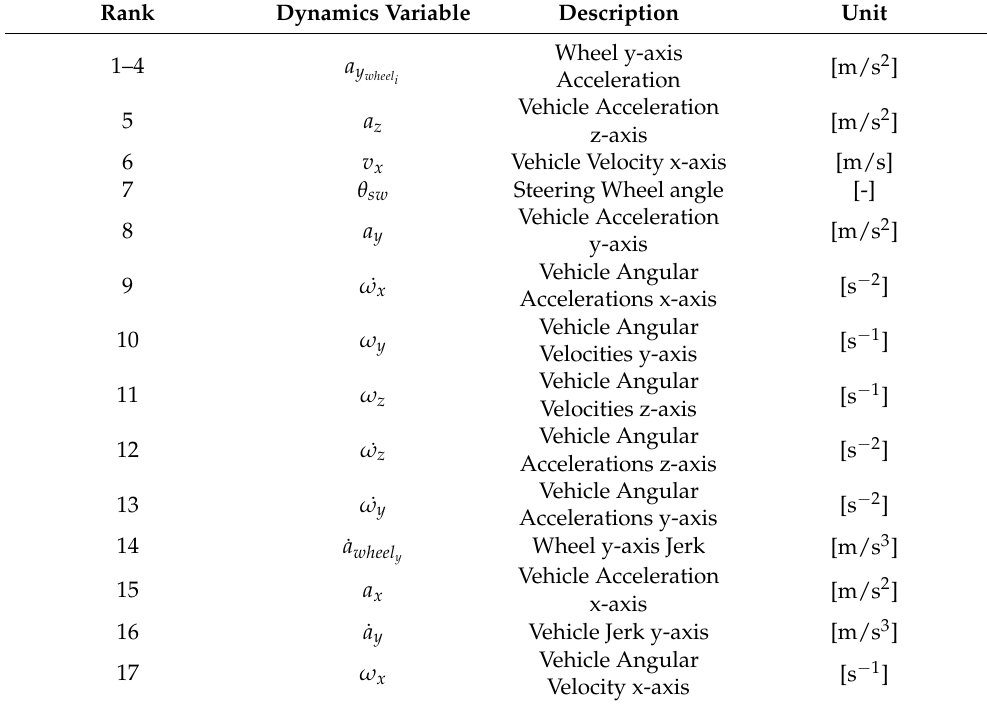
Table 1. Sorted list of linearly related input variables.